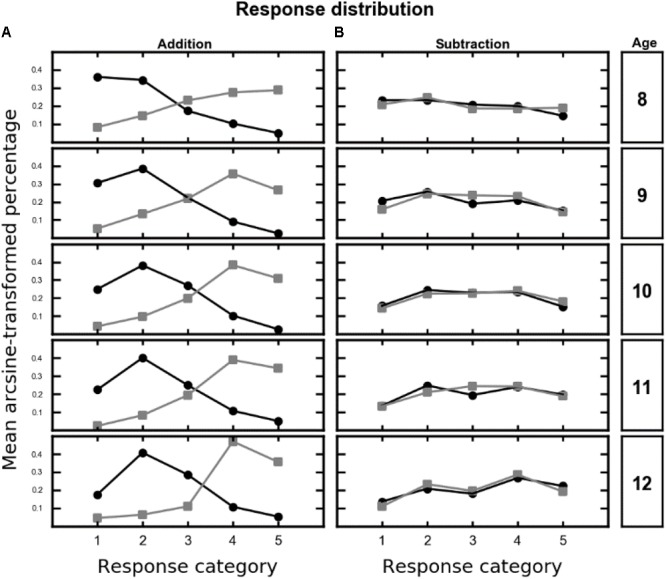
Mean (arcsine-transformed) percentage of choice across the response category (x-axis) as a function of range (high: black circles, low: gray squares) and age (from 8 to 12, rows), for addition (A) and subtraction (B). For high range the correct outcome is the response category 2, for low range the correct outcome is the response category 4.